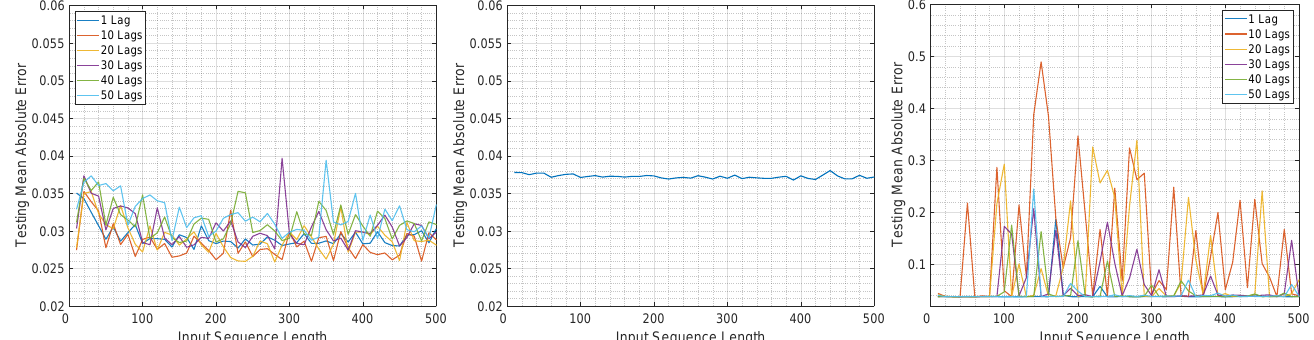
Figure 16. Illustration of the testing mean absolute error value for Experiment 1, LSTMTF ( left ), VLSTM ( middle ), and LSTMTFC ( right ), using a many-to-many prediction mode.